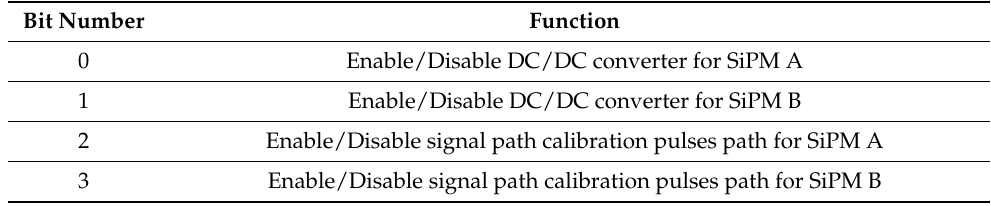
Table 2. Definition of bits in the Control Register.